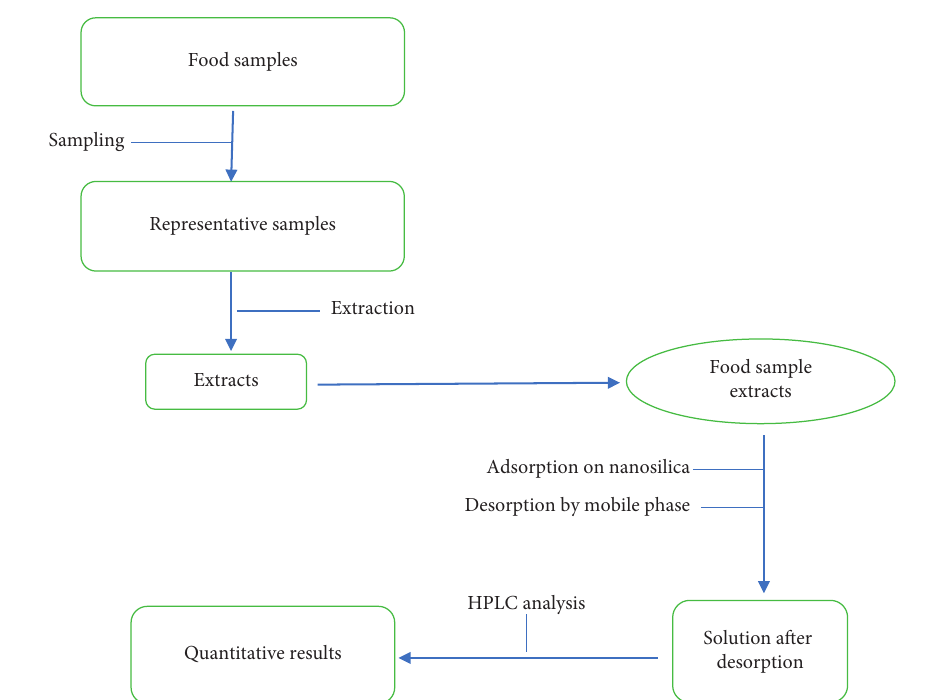
Figure 9: Summary of proposed analytical procedure of food